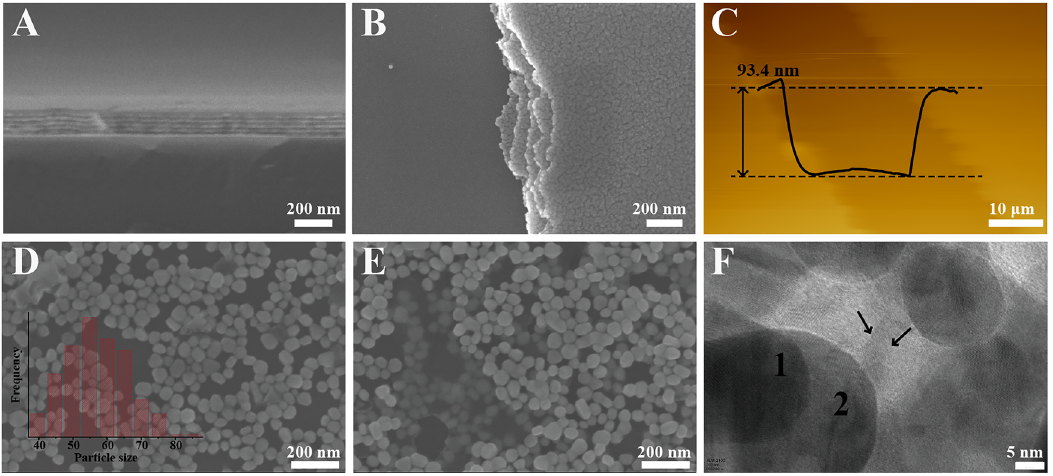
Figure4: (A)Cross-sectionaland(B)topviewscanningelectronmicroscope(SEM)imagesofhyperbolicmetamaterial(HMM).(C)Atomicforce microscopy (AFM) image of the HMM and the corresponding height profile. SEM images of (D) 1Ag and (E) 2Ag. Insert is the size distribution histograms of Ag NPs. (F) Transmission electron microscopy (TEM) image of bilayer Ag NPs